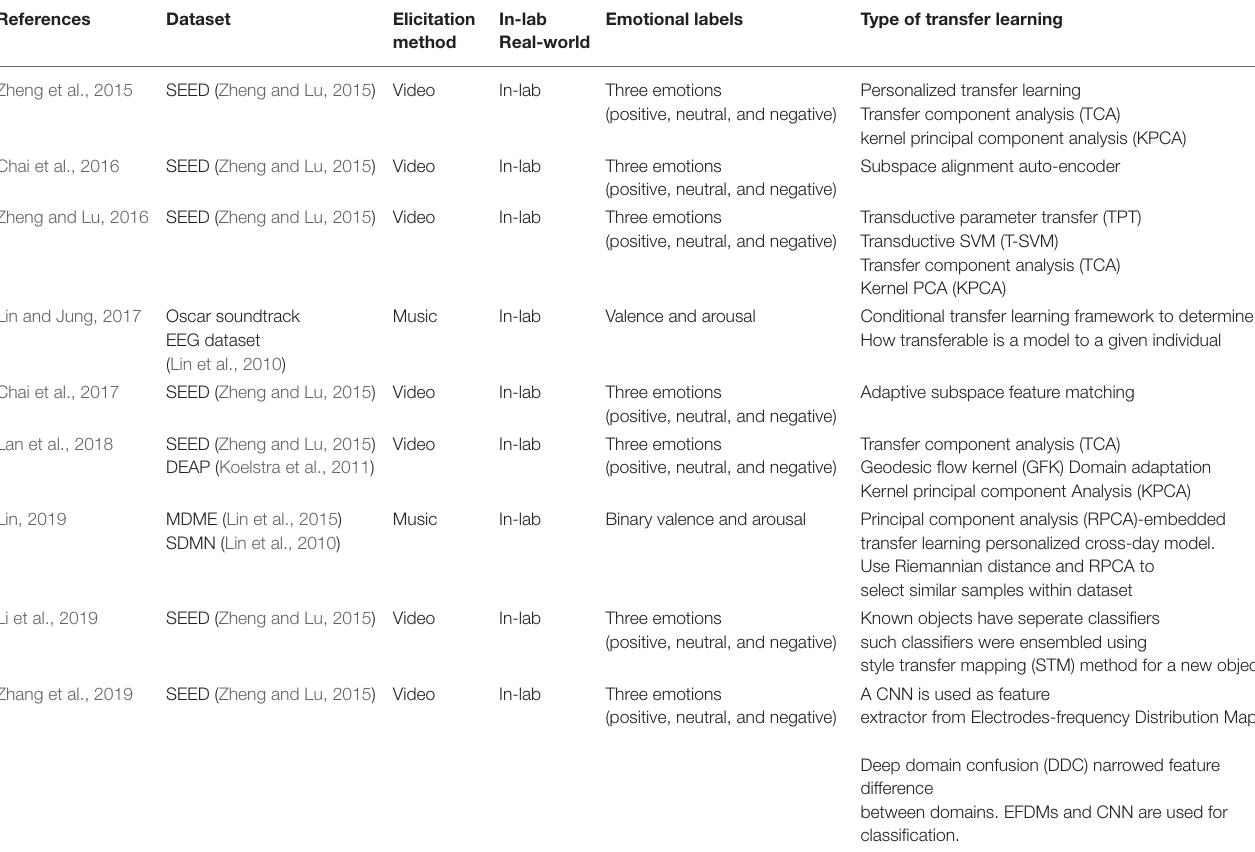
TABLE 3 | Overview of transfer learning methods for emotion recognition based on physiological signals.